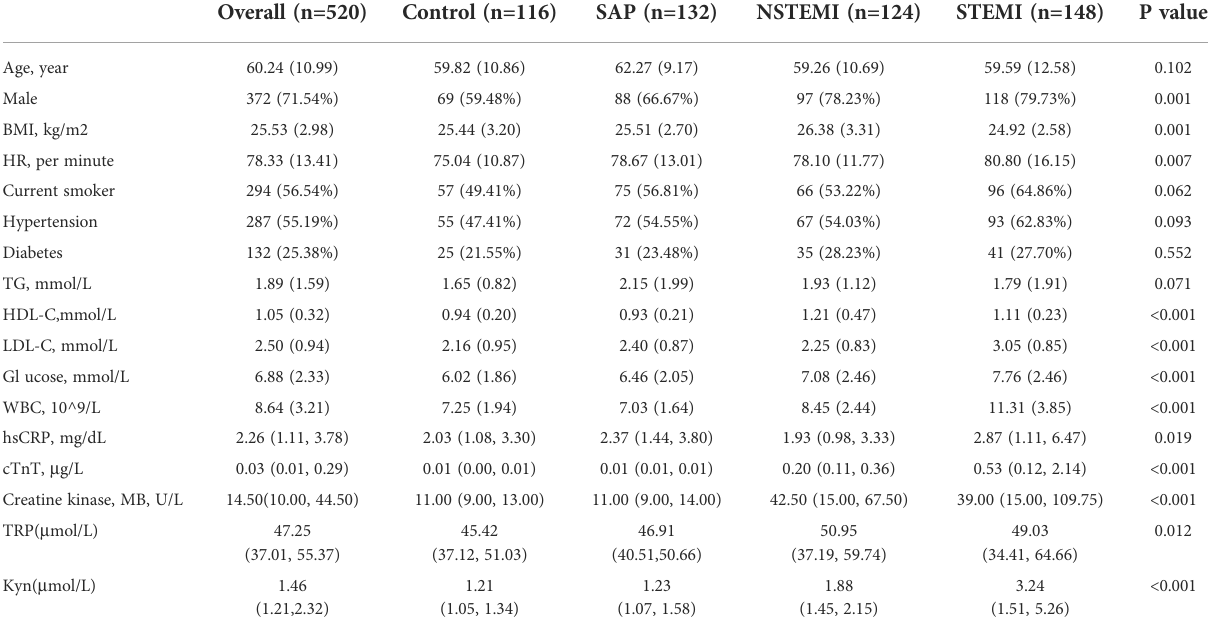
TABLE 1 Baseline characteristics of the recruited